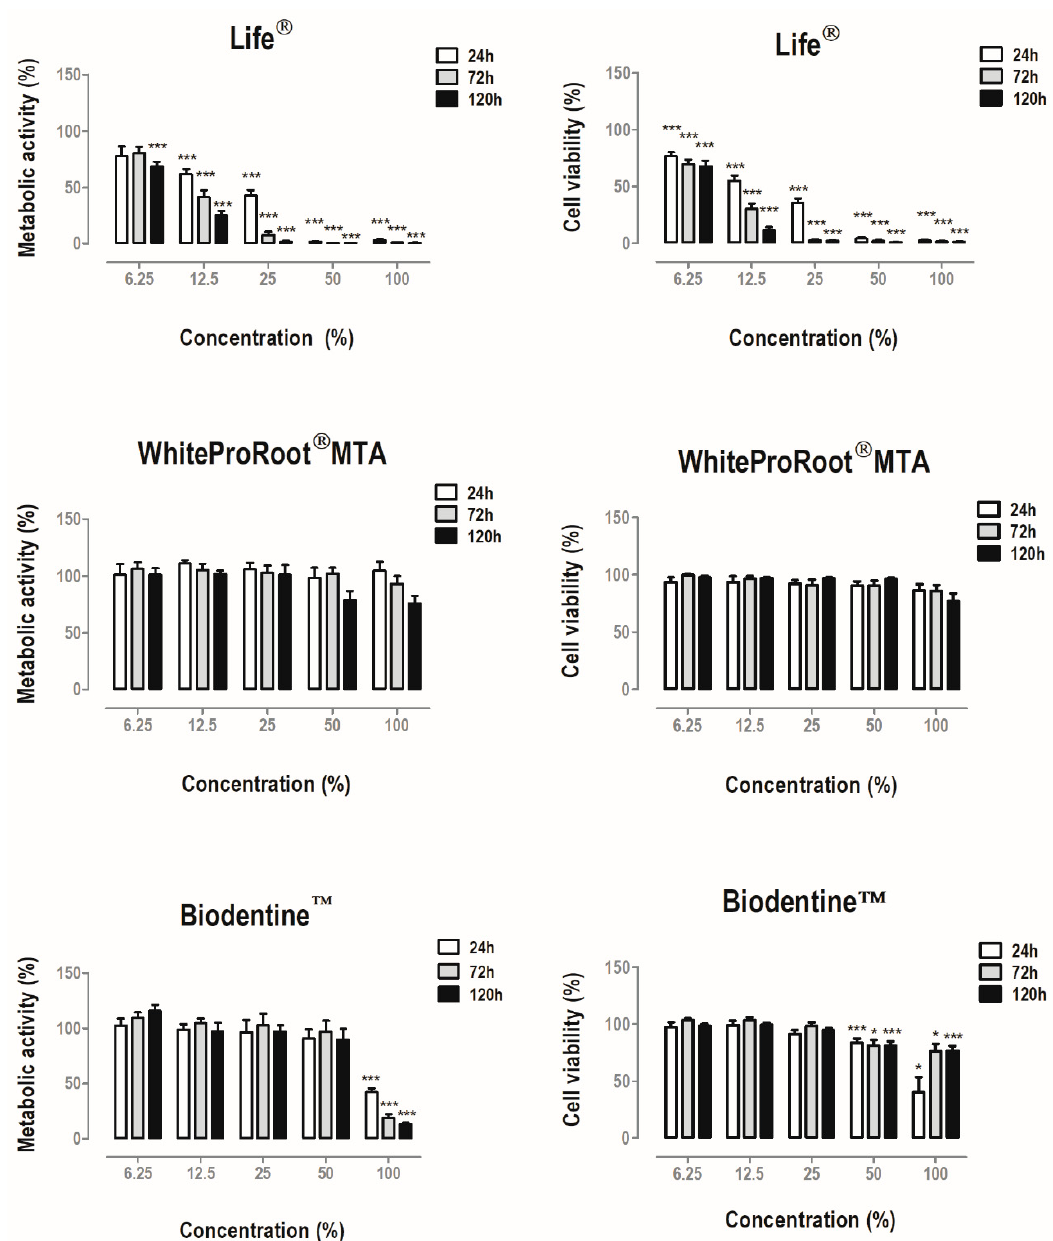
Figure 1. Metabolic activity and cell viability of MDPC-23 cells treated with Life ® , WhiteProRoot ® MTA and Biodentine ™ conditioned media for 24, 72 and 120 h. The results represent the mean and standard error of six independent duplicate assays. Significant differences are represented by *, where * means p < 0.05, ** means p < 0.01 and *** means p < 0.001.